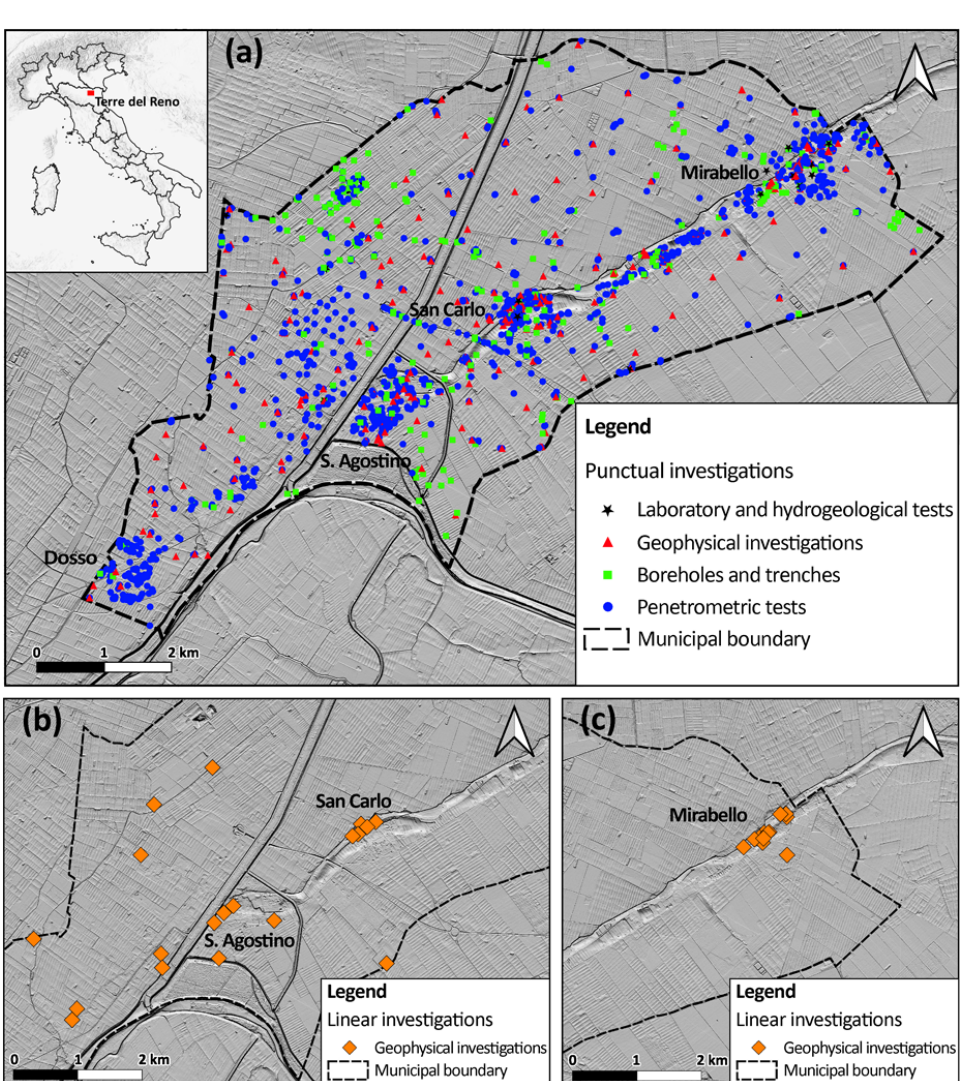
Figure 3. Spatial distribution of the in situ punctual (a) and linear (b, c) investigations composing the PERL dataset. The digital elevation model (DEM) was retrieved from Regione Emilia-Romagna